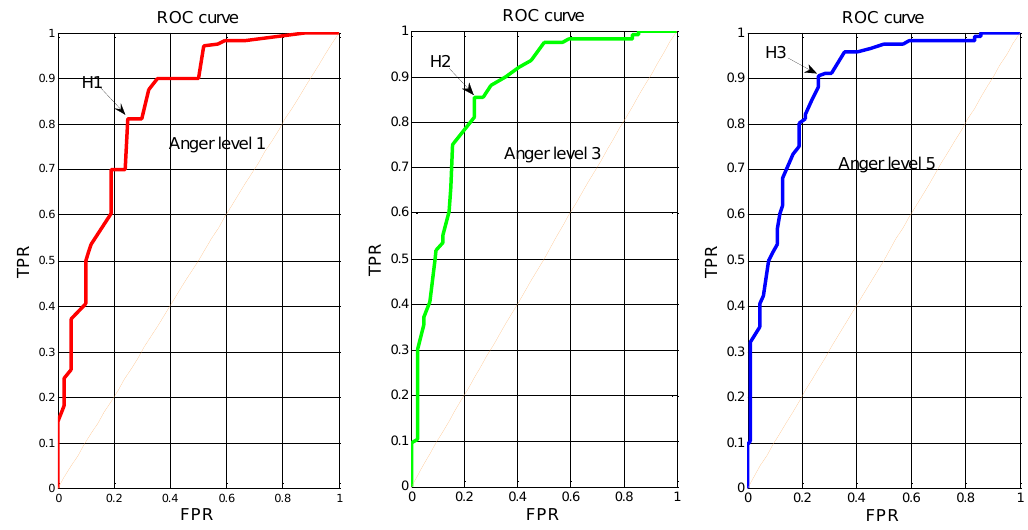
Figure 8. ROC curves of β% at low, moderate and high anger level state.